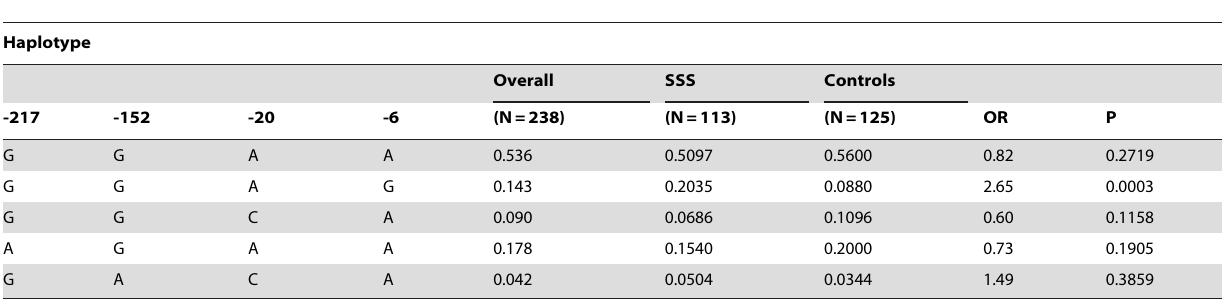
Table 2. Haplotype frequency estimates of AGT gene in patients with sick sinus syndrome and controls.